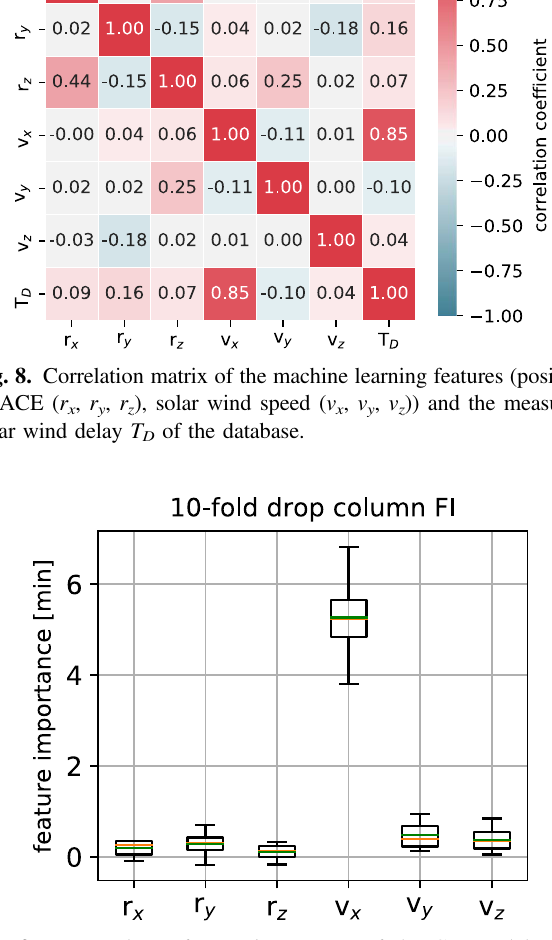
Fig. 9. Drop column feature importance of the GB model using 10-fold cross-validation, whispers show the full range, the box shows the 25%/75% percentiles, the green line indicates the mean, the orange line indicates the